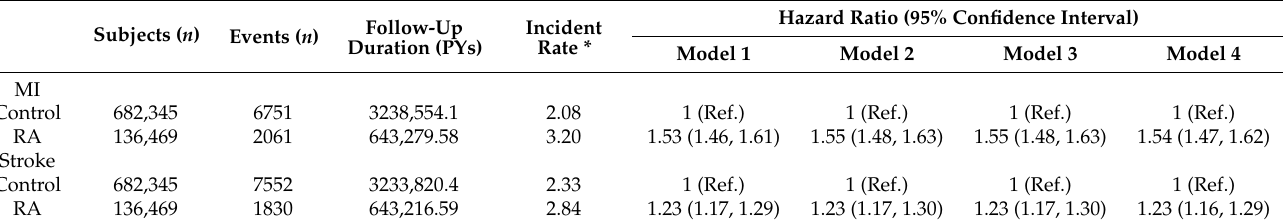
Table 2. Associations between CV events and rheumatoid arthritis.